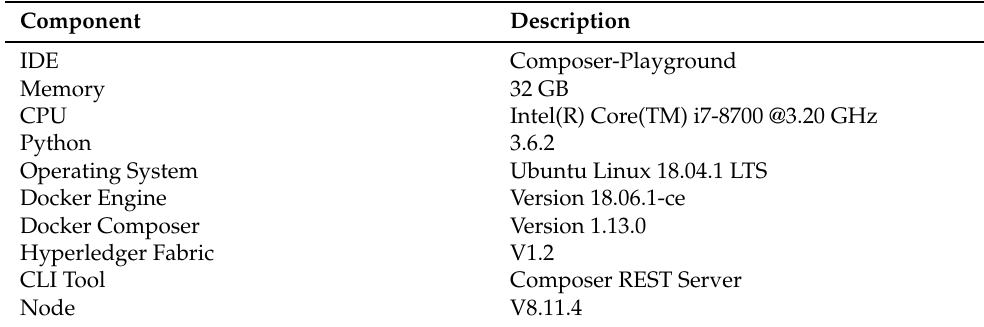
Table 2. Development environment of the proposed system.